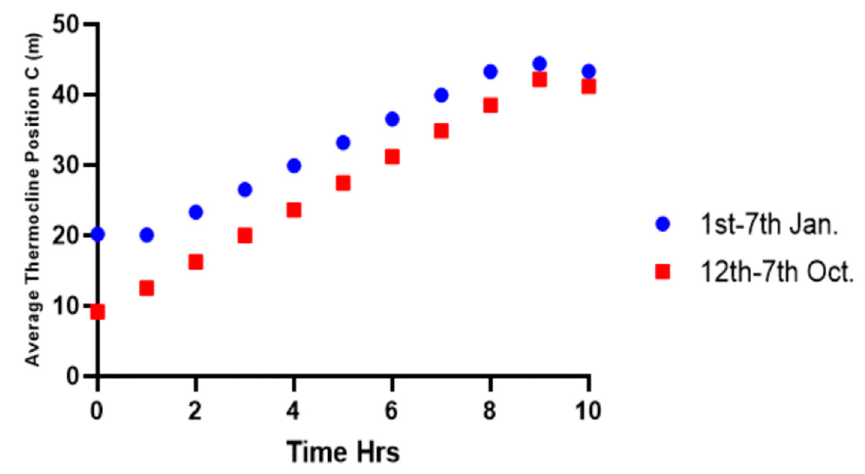
Figure 5. Average Thermocline Position (C) with Time.